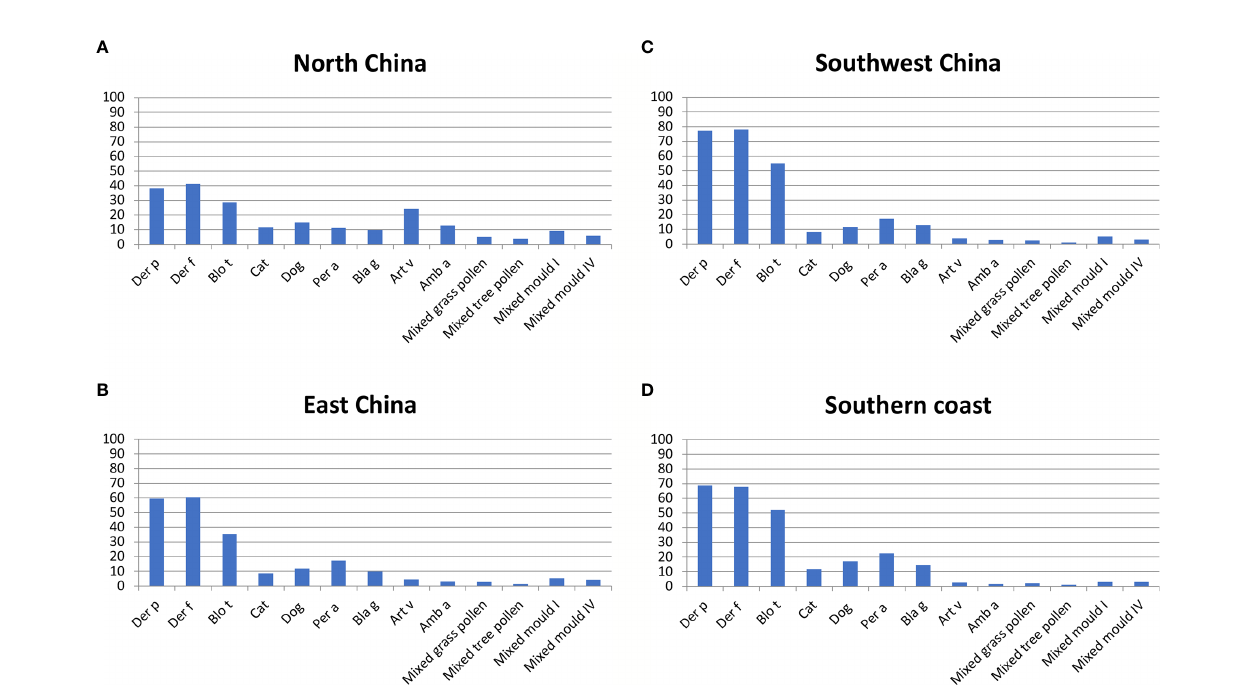
FIGURE 3 | Frequencies (y-axes: percentages of positive subjects) of allergic sensitizations to different allergen extracts according to (26) (x-axes: Der p, Der f, Blo t, cat, dog, Per a, Bla g, Art v, Amb a, mixed grass pollen, mixed tree pollen, mixed mold I and mixed mold IV) as determined by skin prick testing in different areas of China (A) : North China; (B) : East China; (C) : Southwest China; (D) : Southern Coast). Depending on the tested region, frequencies of IgE sensitization varied approximately as follows: Der p: 39-78%; Der f: 40-79%; Blo t: 28-52%; cat: 8-12%; dog: 12-18%; Per a: 10-22%; Bla g: 10-12%; Art v: 3-25%; Amb a: 2-12%; mixed grass pollen: 2-7%; mixed tree pollen: 1-4%; mixed mold I: 3-10%; mold IV: